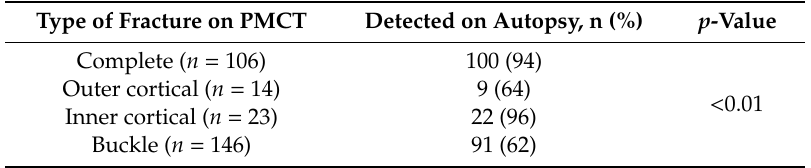
Table 3. Types of rib fractures detected on PMCT and corresponding autopsy findings.